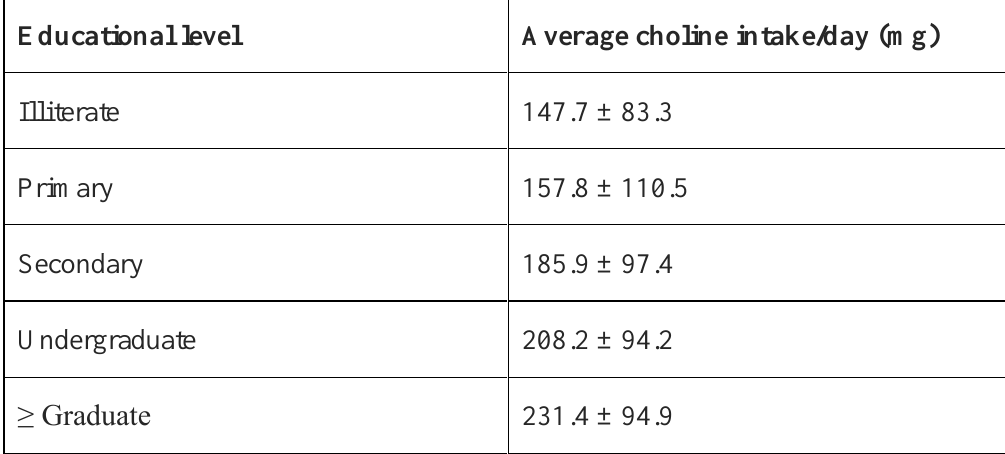
Table 3: Gradual improvement of average choline intake per day with educational